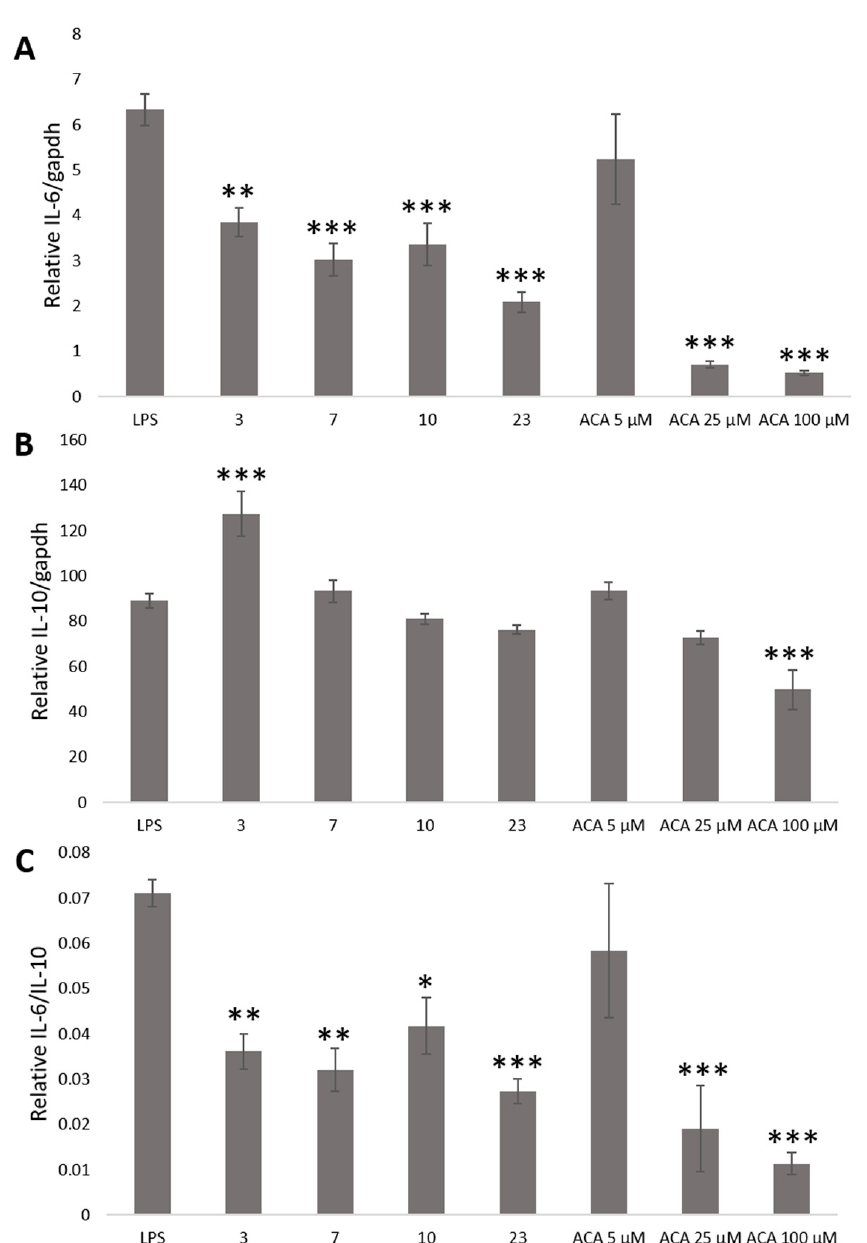
Figure 4. The expression of relative IL-6 / gapdh ( A ), IL-10 / gapdh ( B ), and IL-6 / IL-10 ( C ) by microplate luminometer at 6 h. Stable cells were treated with crude ethanol extracts from nutmeg (3), oregano (7), laurel (10) and long pepper (23) at 75 µ g / mL, 1 (cid:48) S-1 (cid:48) -Acetoxychavicol acetate (ACA) at 5, 25, and 100 µ M from greater galangal and LPS at 100 ng / mL. Each value represents the mean ± SD ( n = 4). * p < 0.05, ** p < 0.01, *** p < 0.001 versus the LPS group. S-1 -Acetoxychavicol acetate from greater galangal ( Alpinia galangal ) has been studied mainly for (cid:48) anti-cancer [34–39]. Although, it was reported that S-1 -Acetoxychavicol acetate from Languas galangal suppressed NO production in LPS-induced RAW 264.7 cell with dose-dependent [40]. However, (cid:48) we found that S-1 -Acetoxychavicol acetate from greater galangal could reduce IL-6 level and increase IL-10 level. This discovery may lead to develop new drug for balancing pro-inflammatory and anti-inflammatory activity and chronic inflammatory